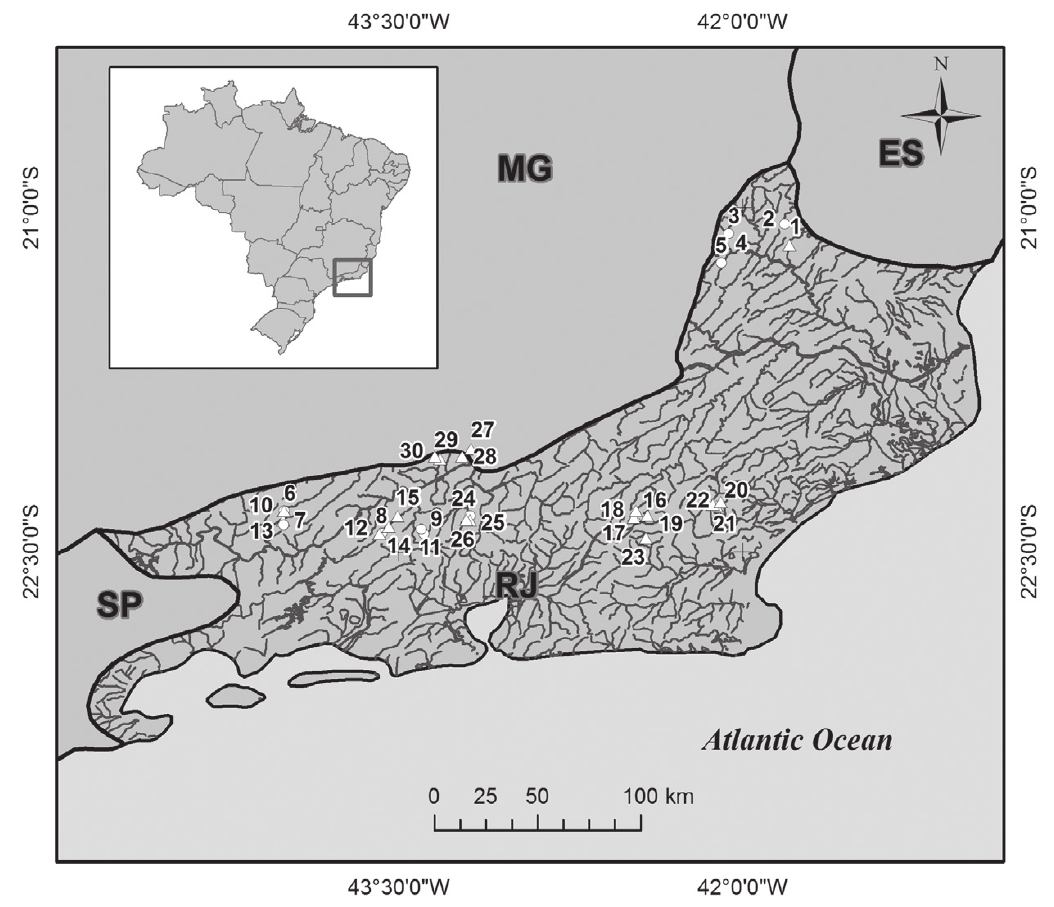
Figure 1 - Map of the state of Rio de Janeiro, showing the sampled fishponds. Circles = fee-fishing systems; triangles = fish-farming systems. MG = Minas Gerais, ES = Espírito Santo, RJ = Rio de Janeiro, SP = São